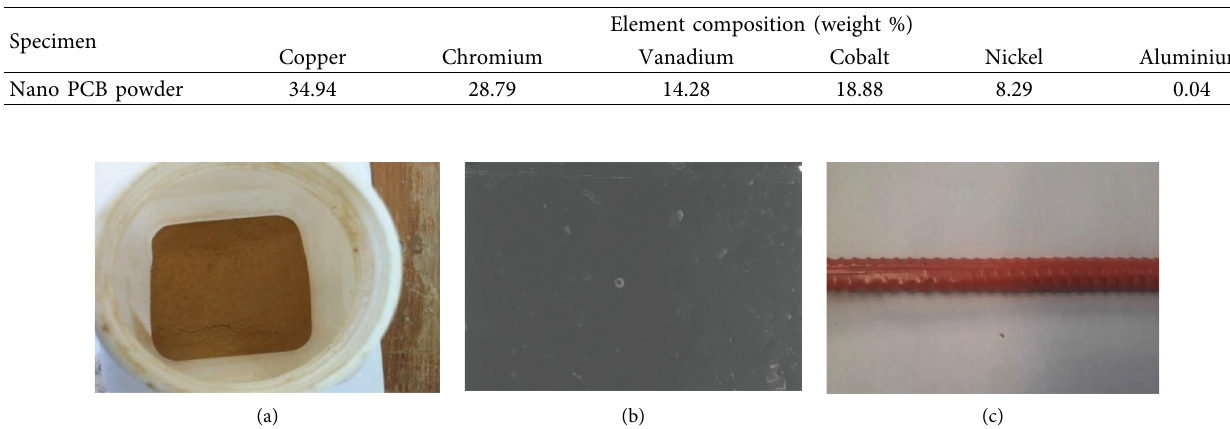
Table 1: Chemical composition of nano PCB.